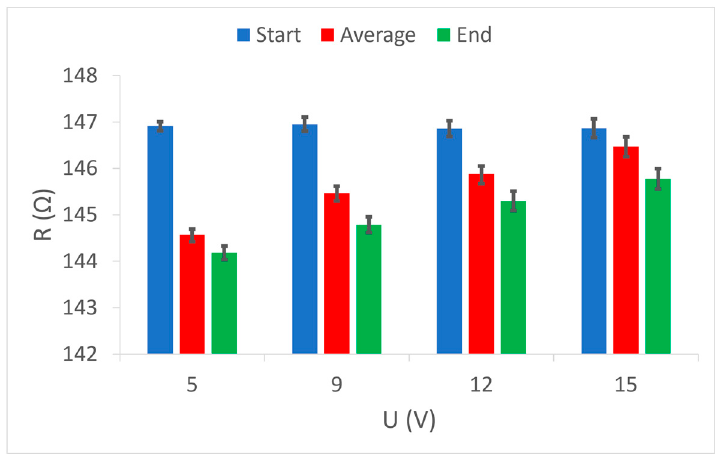
Figure 10. Comparison of three resistance values (start, average, end) at given voltage values in sample 2.